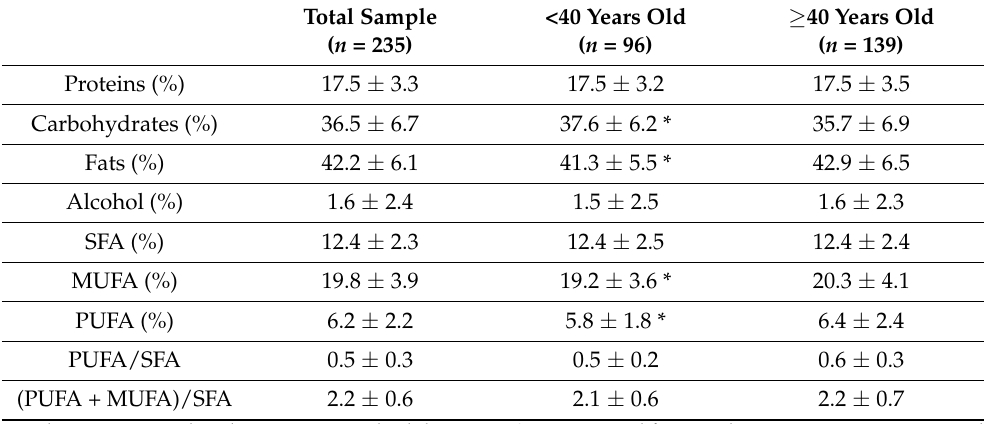
Table 3. Contribution of macronutrients to the total energy and dietary fat quality